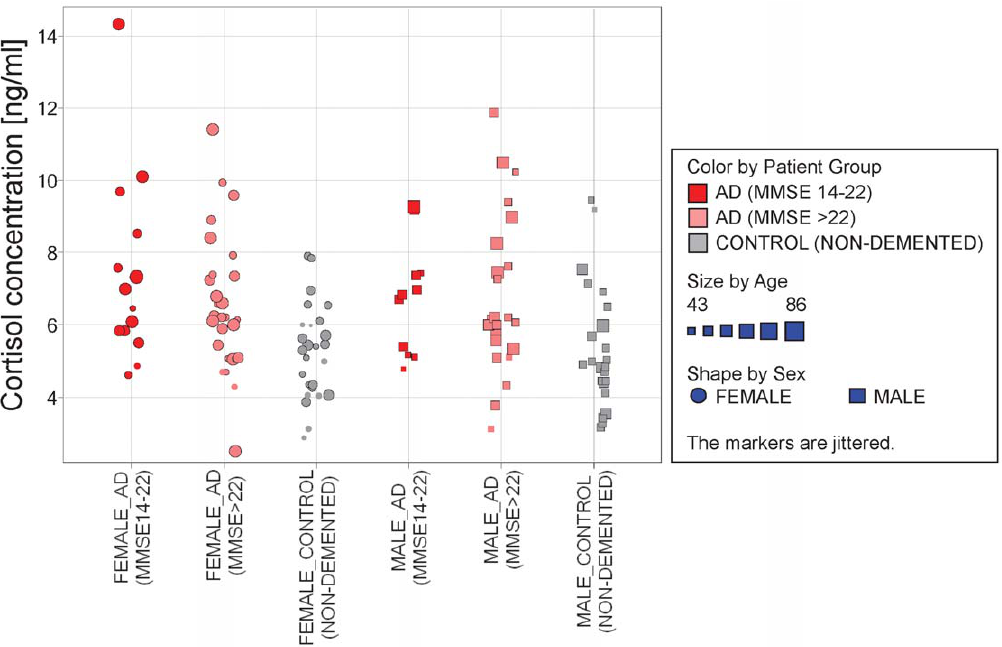
Figure 2.Increase of cortisol concentration observed for AD patients compared to healthy controls. doi:10.1371/journal.pone.0031501.g002 PLoS ONE |